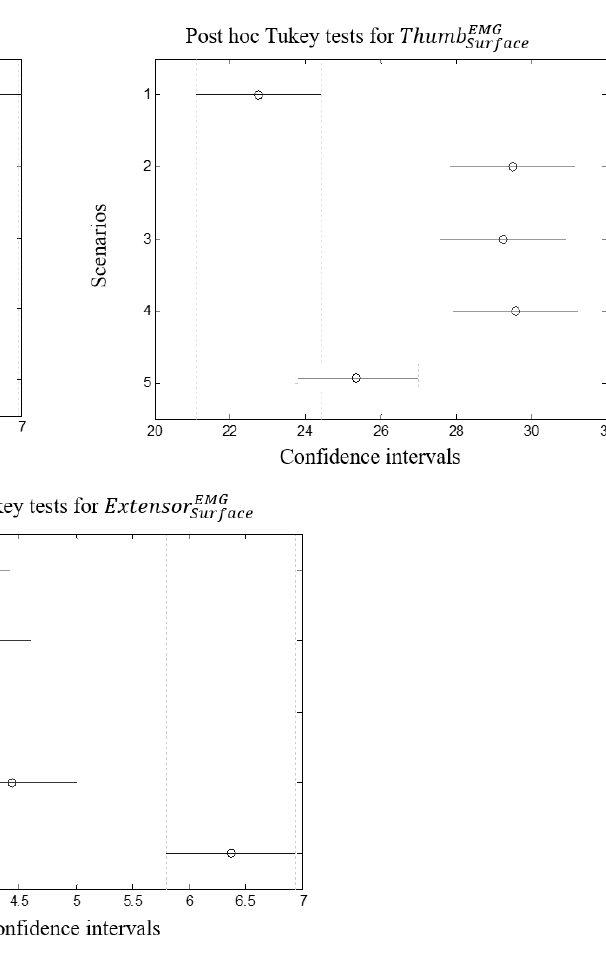
, Thumb EMG and Max Surface